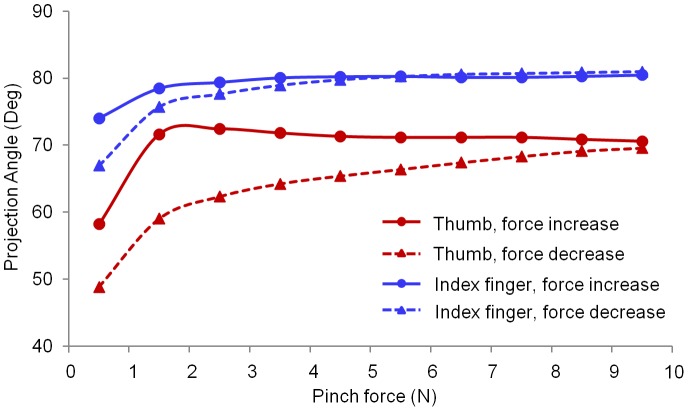
Force projection angles for the thumb and index finger.Each data point represents the average of PA for all trials within the specified 1-N force interval.